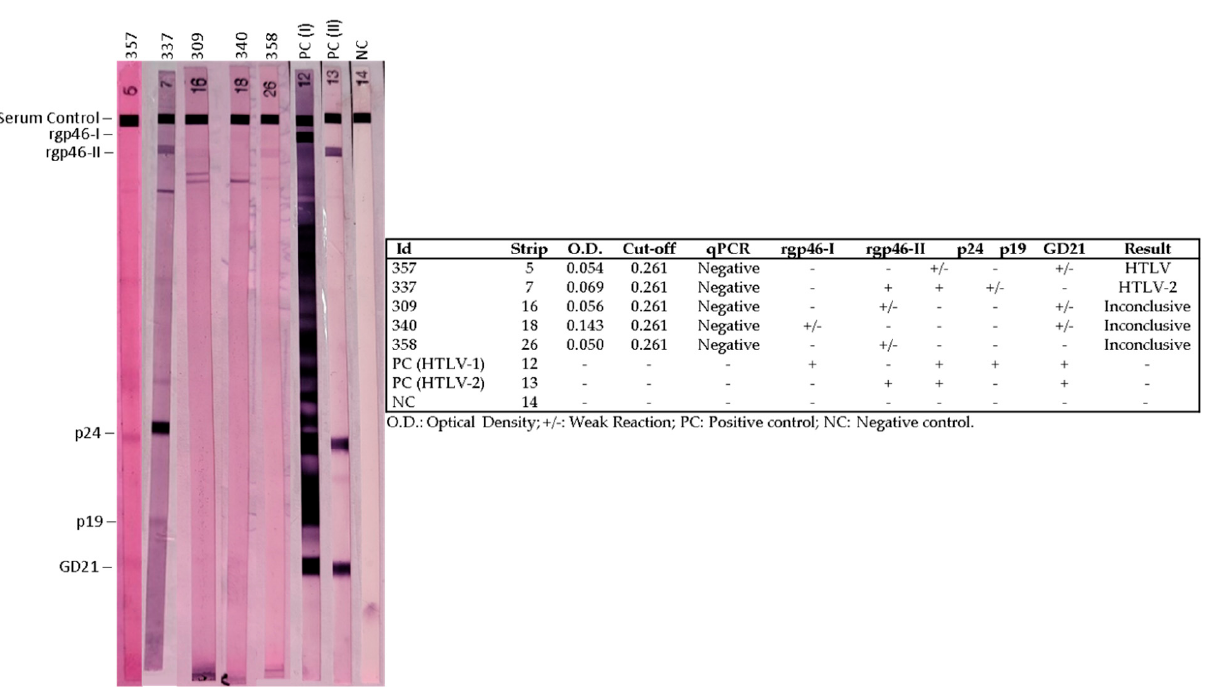
Figure 2. HTLV ‐ 1/2 reactivity patterns on Western blot analysis. Strips 5, 7, 16, 18 and 26 Figure 2. HTLV-1/2 reactivity patterns on Western blot analysis. Strips 5, 7, 16, 18 and 26 correspond correspond to samples from the Kayapó people, 4 from the Kararaô subgroup (strips 7, 16, 18 and to samples from the Kayap ó people, 4 from the Karara ô subgroup (strips 7, 16, 18 and 26) and one 26) and one from the Xikrin do Bacajá subgroup (strip 5). Strips 12, 13 and 14 correspond to the from the Xikrin do Bacaj á subgroup (strip 5). Strips 12, 13 and 14 correspond to the HTLV-1 positive, HTLV ‐ 1 positive, HTLV ‐ 2 and negative controls, respectively. HTLV-2 and negative controls,